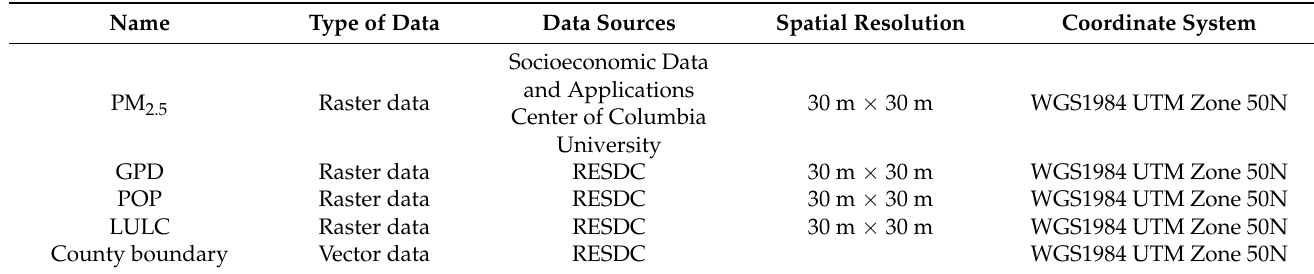
Table 1. Data sources and